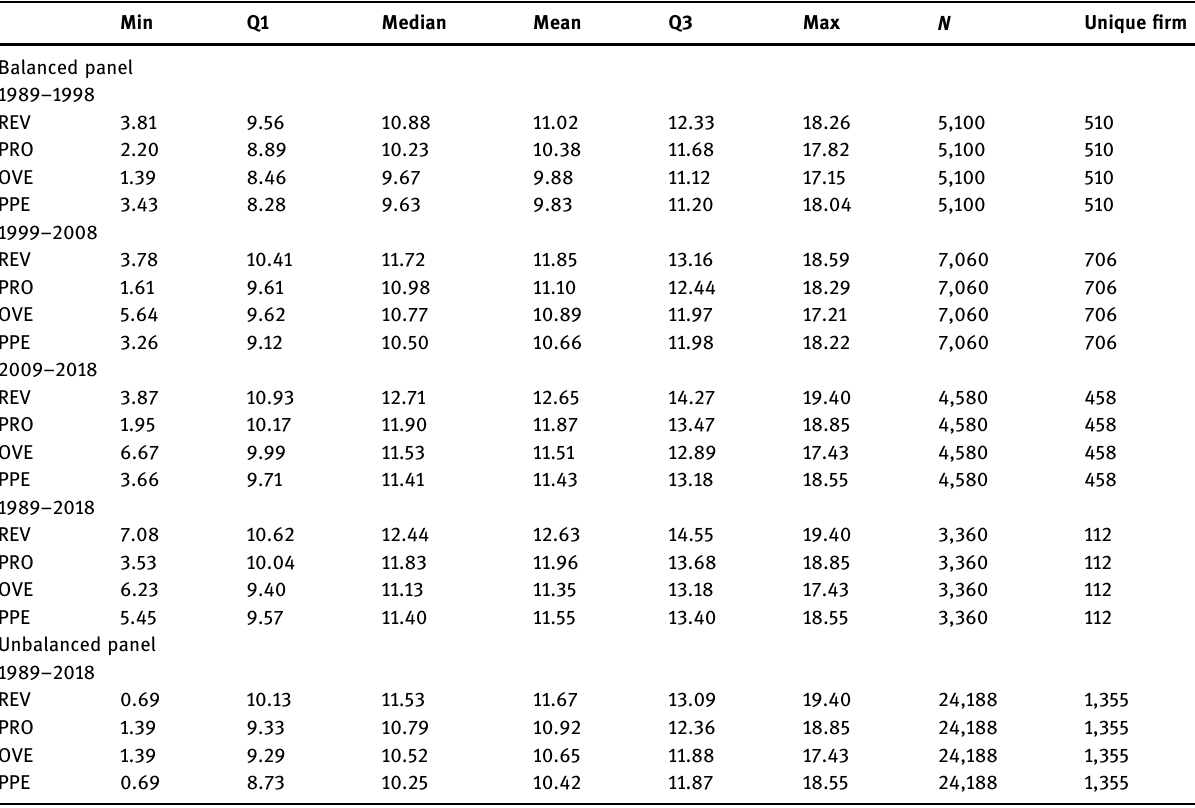
Table 1: Descriptive statistics Min Q1 Median Mean Q3 Max N Balanced